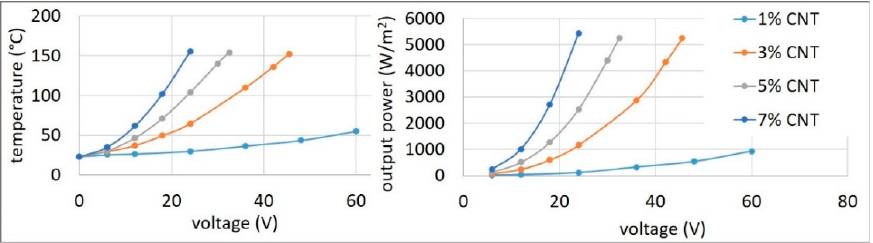
Figure 5. Increase in temperature ( left ) and output power ( right ) with voltage at different CNT concentrations.